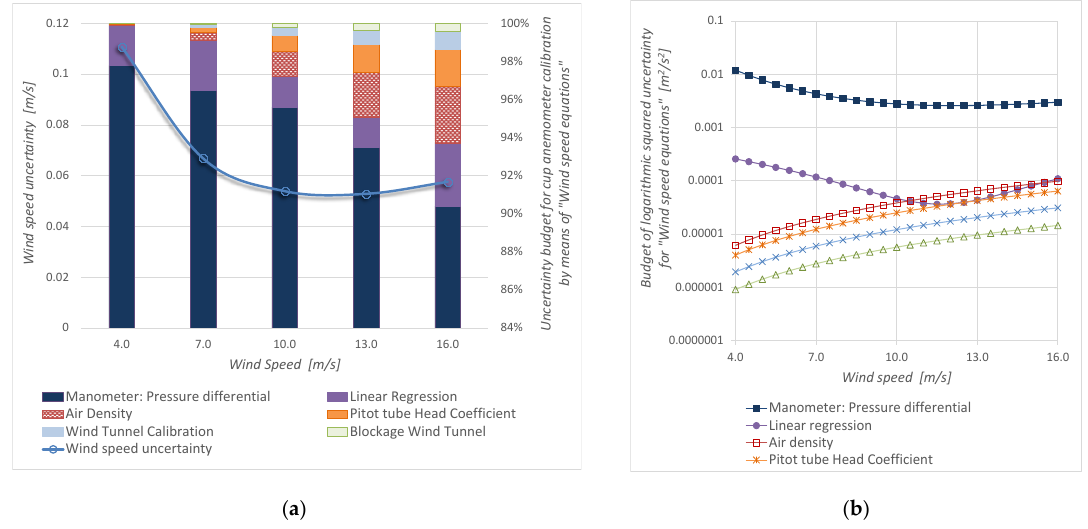
Figure 7. Measurement uncertainty: ( a ) “Wind speed equations” (AS-Cup anemometer measurement method), ( b ) “Wind dynamic pressure equations” (DYP-Cup anemometer measurement method).